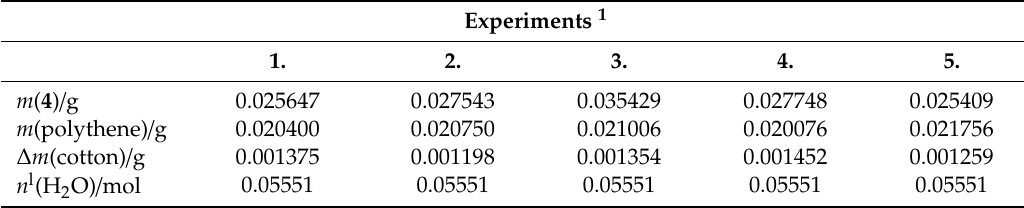
◦ (cotton fuse) = 2.07 J K − 1 g − 1 , ∆ u p ( 4 ) c